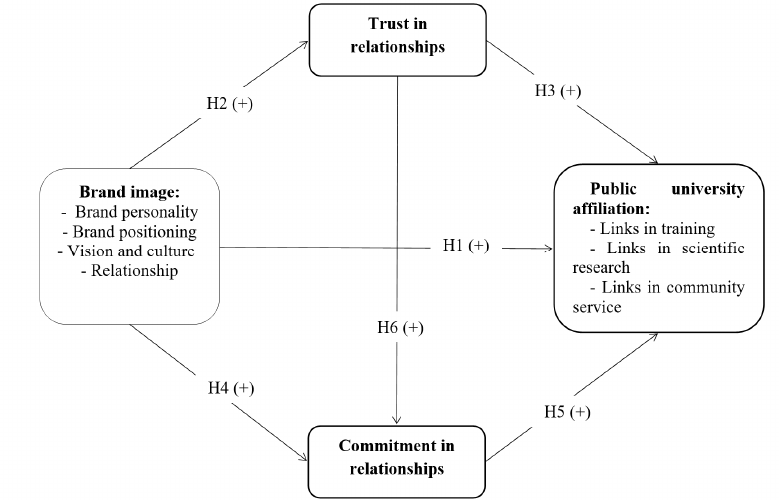
Fig. 1. The proposed